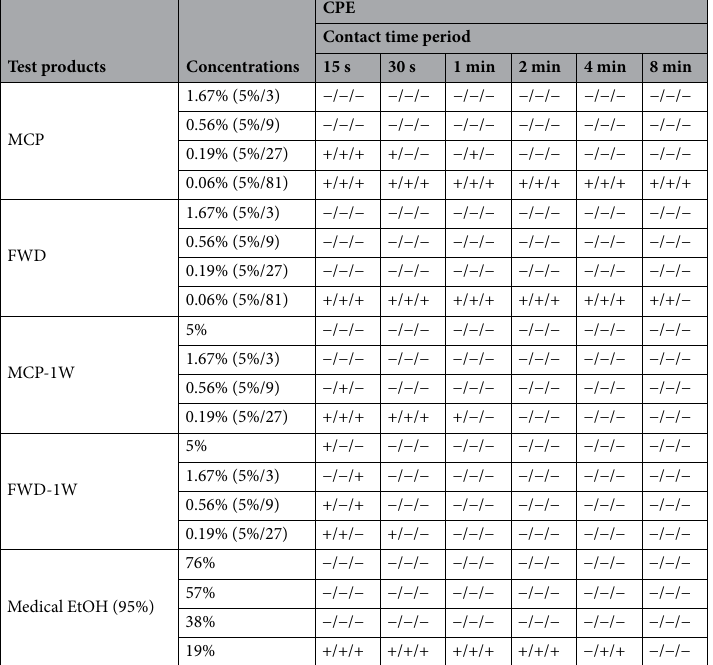
Table 3. CPE of infected cells in each test was observed after virus incubation for different time with different final concentration of MCP, FWD and medical ethanol.